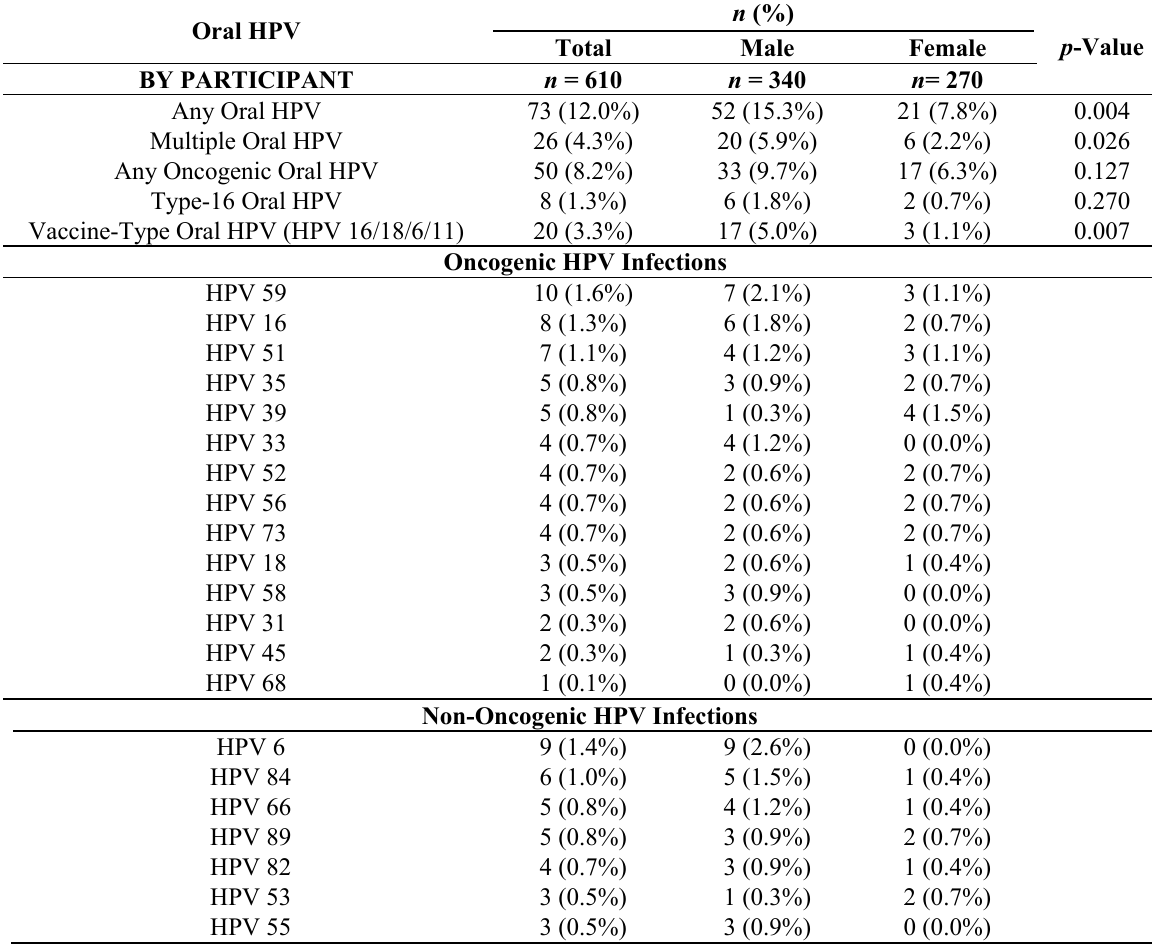
Table 3. Oral HPV prevalence by